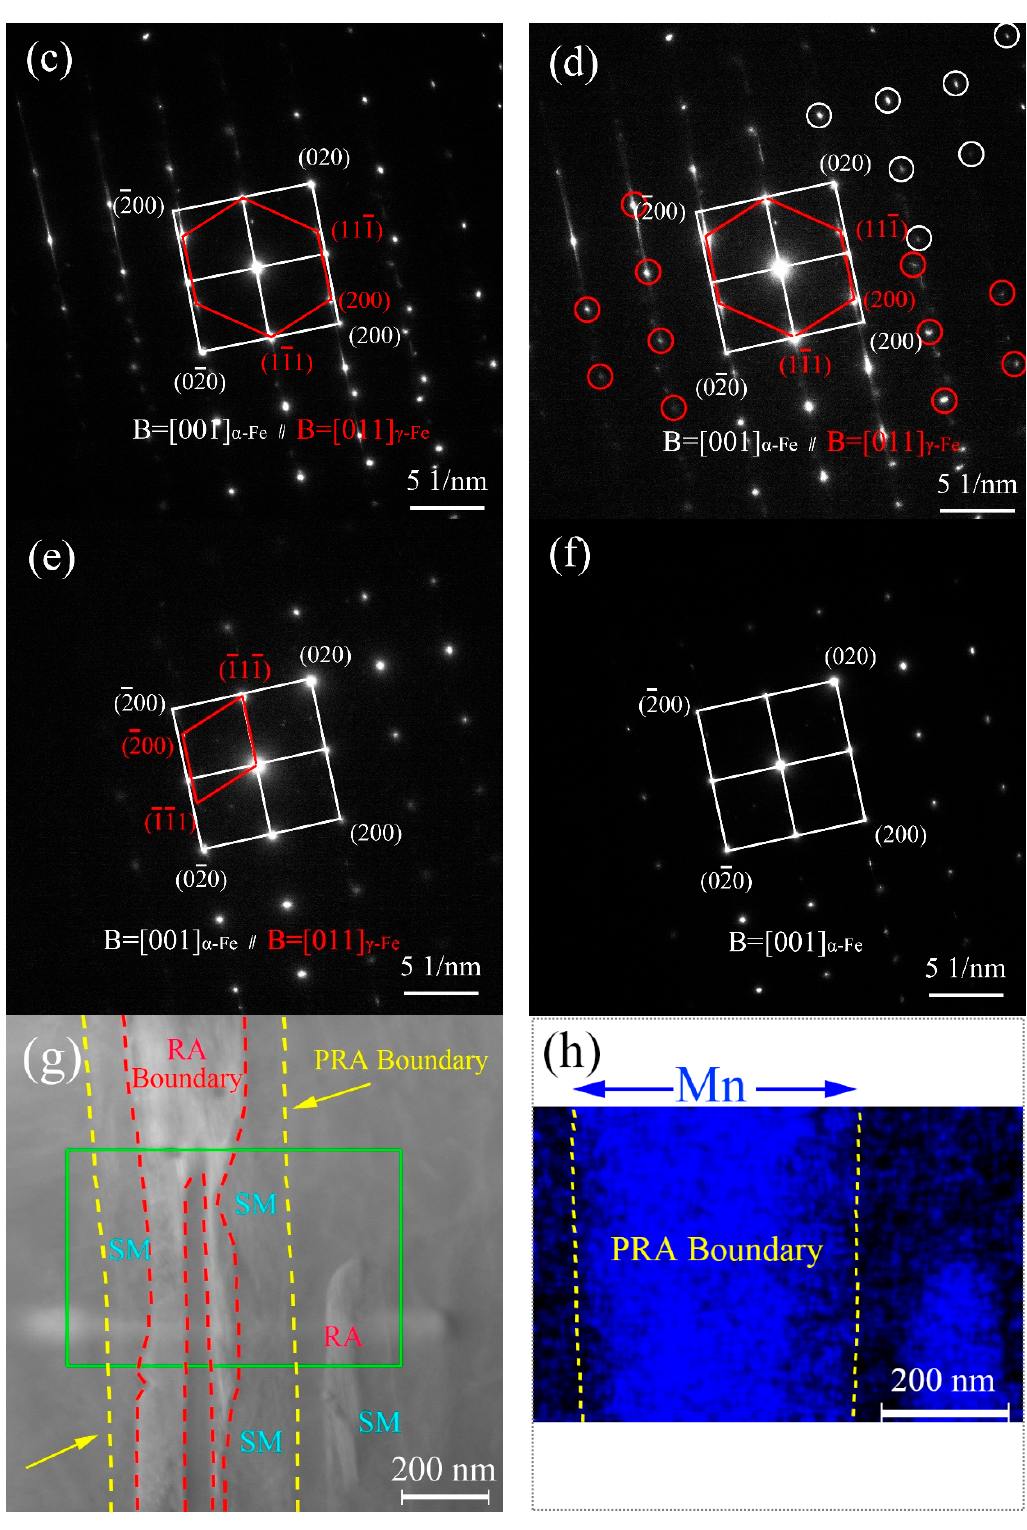
Figure 8. TEM images after being tempered at 200 °C with IA-12 h: ( a ) bright field image; ( b – f ) the SAED patterns from point 1 to point 5 marked by red circle in Figure 8a; ( g ) the image, corresponding to Figure 8a, of scanning TEM mode; ( h ) Mn map distribution.